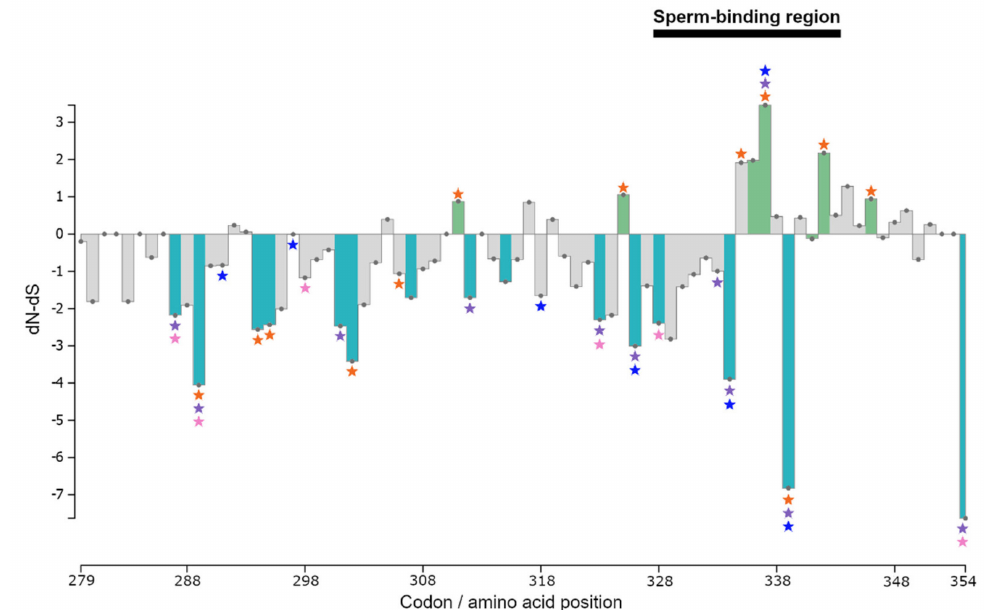
Figure 3. Distribution of amino acid sites under selection in exons 6 and 7 of ZP3 as identified by PAML site models M2a, M3, and M8 and by HyPhy site tests SLAC, FEL, FUBAR, and MEME ( p < 0.05). For the Cricetidae + Murinae data set, dN-dS columns corresponding to sites indicated as possibly being under positive selection by either all PAML models or all HyPhy tests are denoted in green, while columns of negatively selected sites in all HyPhy tests are shown in light blue. Grey columns correspond to sites that were not inferred to be under either positive or negative selection in all PAML and/or HyPhy tests. Coloured stars indicate sites selected only in particular data sets: purple = Cricetidae; orange = Murinae; blue = Microtus ; and pink = Peromyscus . The normalized dN-dS per codon was calculated by